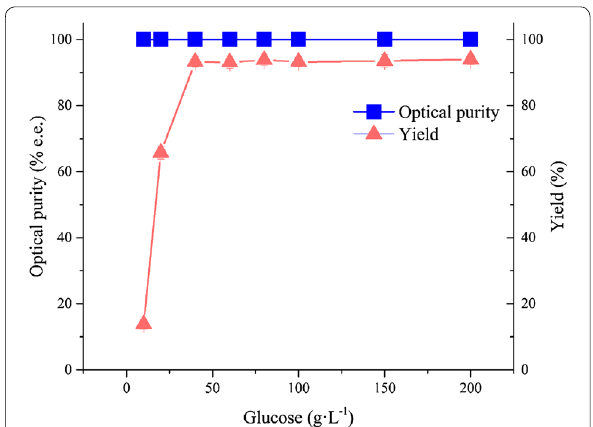
Fig. 6 Effect of glucose concentration on CR2-L-GDH catalyzing asymmetric synthesis of ( S )-DHTP. All reactions were carried out in 10 mL TEA buffer (0.1 mol L − 1 , pH 8.4) comprising 20 g L − 1 DKTP with addition of 0.2 mmol L − 1 NADP + at 40 °C and 200 rpm for 10 h. All the results were the average of three parallel